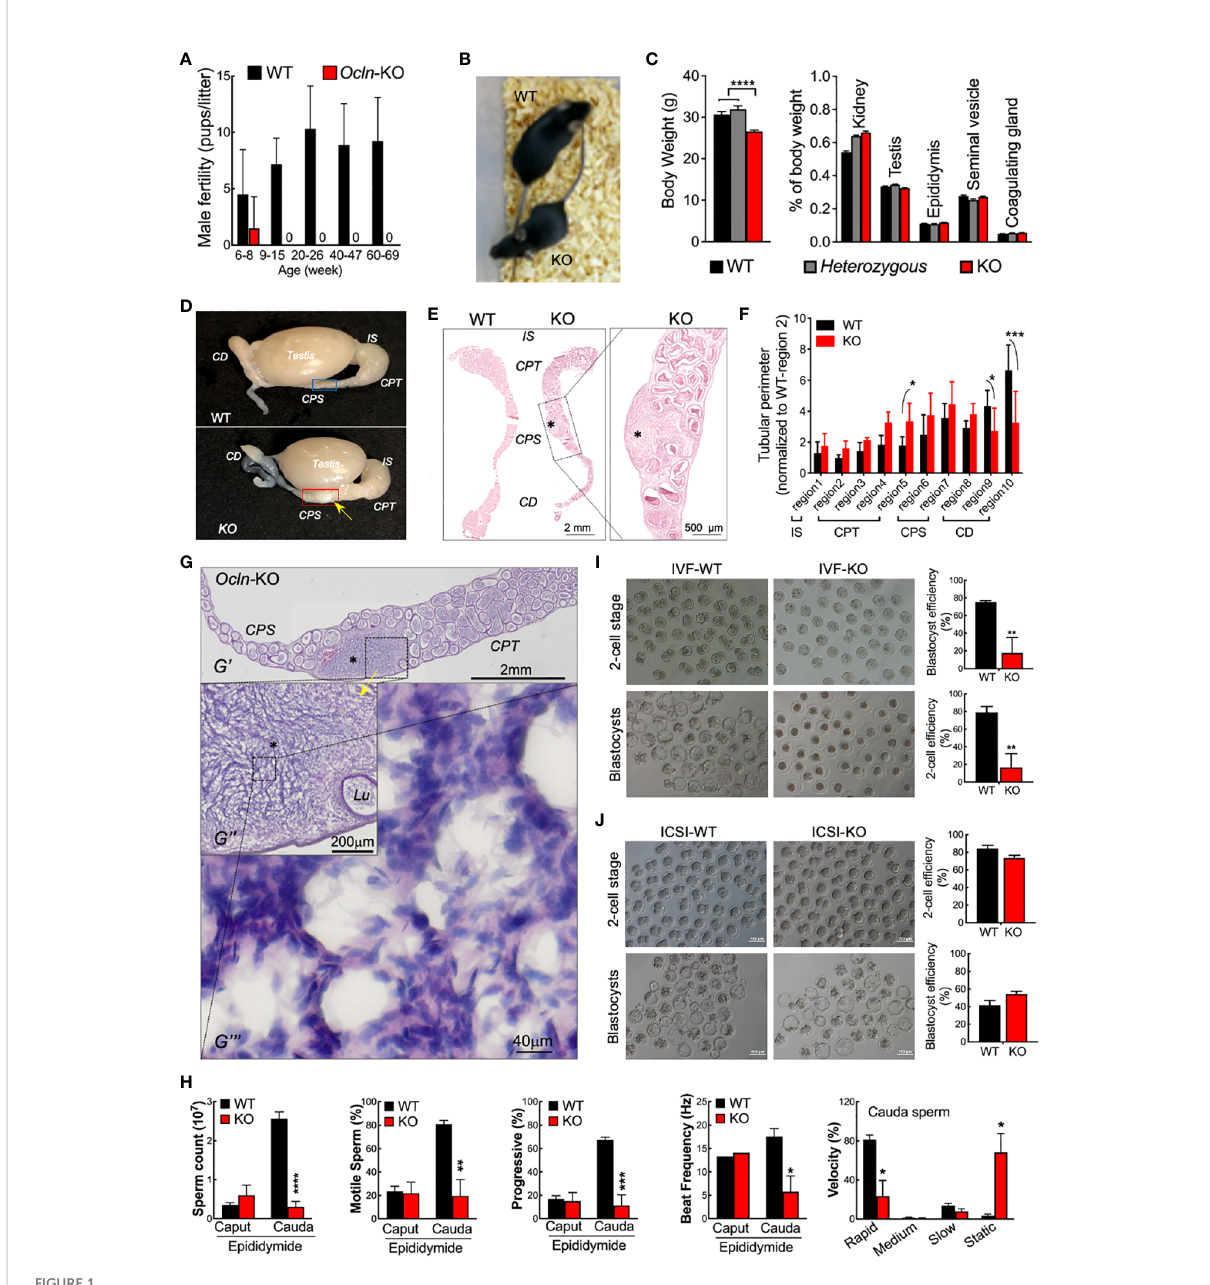
FIGURE 1 Dysfunction epididymal function rather than testicular spermatogenesis underlies the male infertile in OCLN-de fi cient mice. (A) Fertility test con fi rmed infertility of adult but not juvenile Ocln- KO male mice. (B) Appearance, body weights and relative organ weights (C) of WT, heterozygous and Ocln- KO male mice. (D) Gross anatomy showing granuloma-like tissue knot (yellow arrow) in Ocln- KO but not in WT epididymis. (E) Alizarin red S staining showed enlarged CPS but degenerated CD epididymidis of Ocln- KO mice compared with WT. Asterisks: granuloma-like structure in the Ocln- KO CPT-CPS conjunctions. (F) Regional tubular perimeters of epididymis of WT and Ocln- KO epididymis. Annotations of the different epididymal segments were as described previously (40), viz. region 1 for initial segment (IS), region 2-5 for caput (CPT), region 6-7 for corpus (CPS), and region 8-10 for cauda (CD) epididymidis. (G) H&E staining showing granuloma-like tissue knot (asterisks) in the CPT- CPS junction of an Ocln- KO epididymal cryosection ( G ’ ). Intermediate resolution image showing the enlarged interstitial space fi lled with many sperm next to the distorted tubule ( Lu ) ( G ’’ ). Higher resolution image showing that numerous sperm, characterized by their oval- shaped head (purple) and curved tail (pink), essentially fi lling the space of the enlarged interstitial tissue ( G ’’’ ). (H) Decreased sperm counting of cauda sperm but not caput sperm and CASA parameters showing impaired motility of Ocln- KO cauda sperm. (I) IVF (I) and ICSI (J) assay results using cauda epididymidal spermatozoa of WT or Ocln- KO mice. Data were means ± SD from (n > 3 animals per group). * P <0.05, ** P <0.01, *** P <0.001, **** P <0.0001, one- or two-way